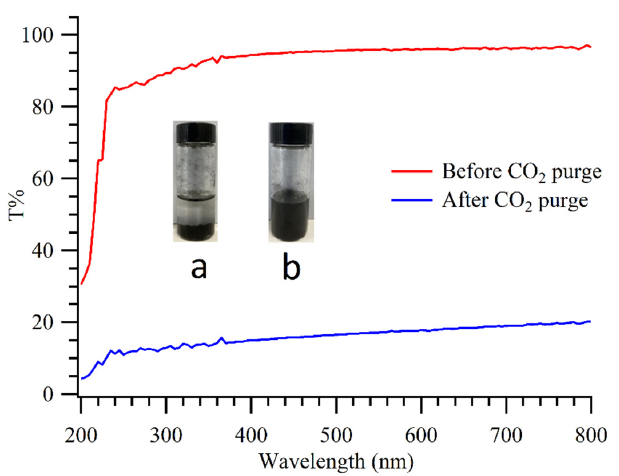
Figure 3. TEM of MWCNTs.